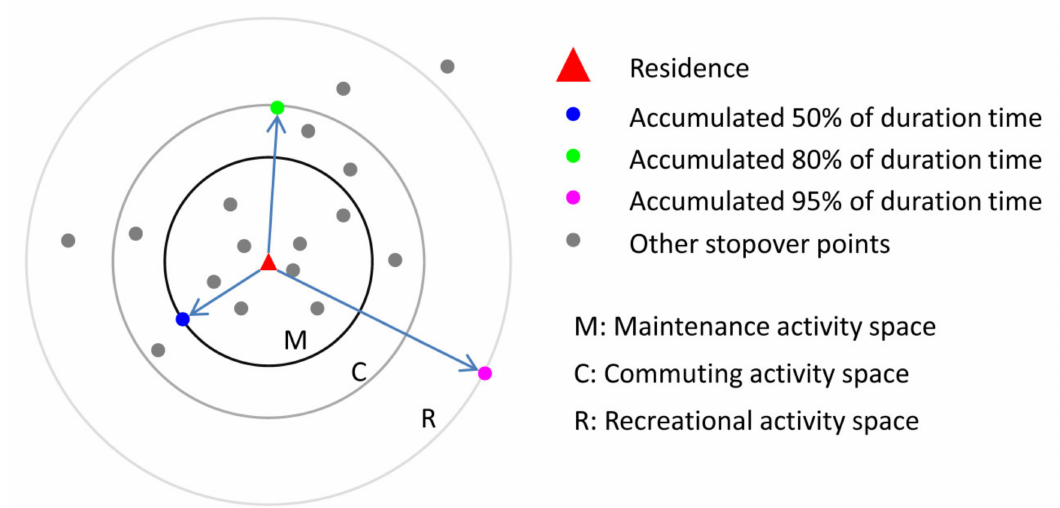
Figure 3. Definition of three activity spaces. Circle dots mean the main stopover points of residents. Three types of activity spaces have their own geographic scales, and they occupy di ff erent ratios of a lifetime. Therefore, the stopover point that accumulated the corresponding ratio of time represents the farthest place of that activity, and distance between the stopover point and home is the radius of that activity